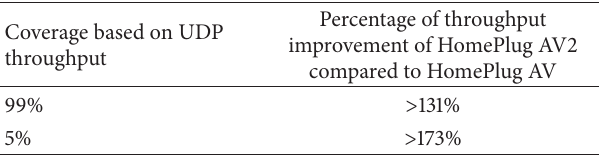
Table 2: Improvement of HomePlug AV2 in a 4-node